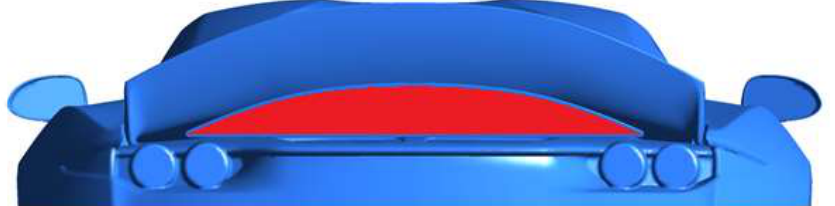
Figure 11. Rear view of the car with spoiler and booster plate (red element) in the aerodynamic braking setup.